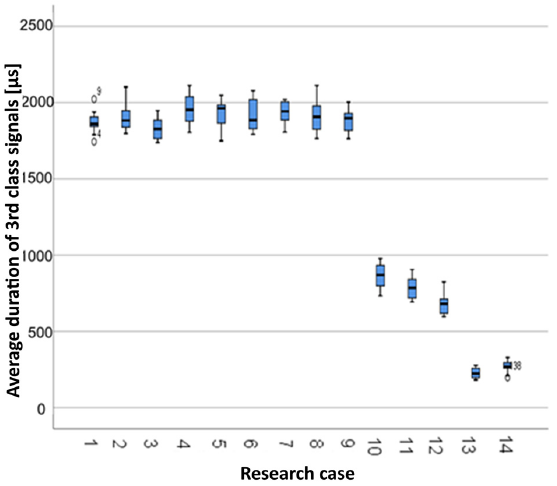
Figure 24. The graphical representation of the Kruskal–Wallis test results for independent tests of the average duration of the class 3 signals.